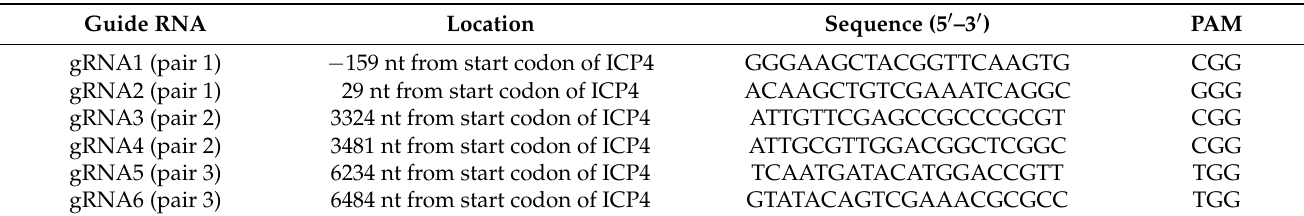
Table 1. List of six designed gRNAs targeting the ICP4 gene of Marek’s disease herpesvirus (MDV). Guide RNA